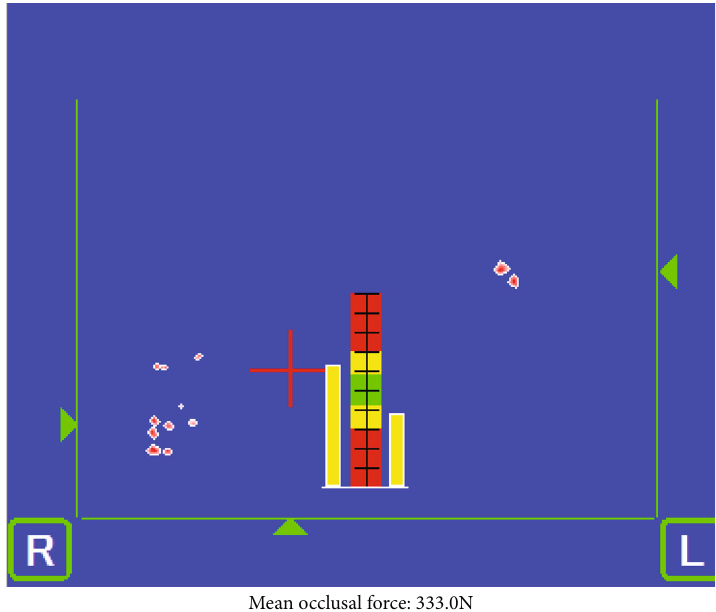
Figure 2: Occlusion state at reevaluation visit. Mean occlusal force: 333.0 N.